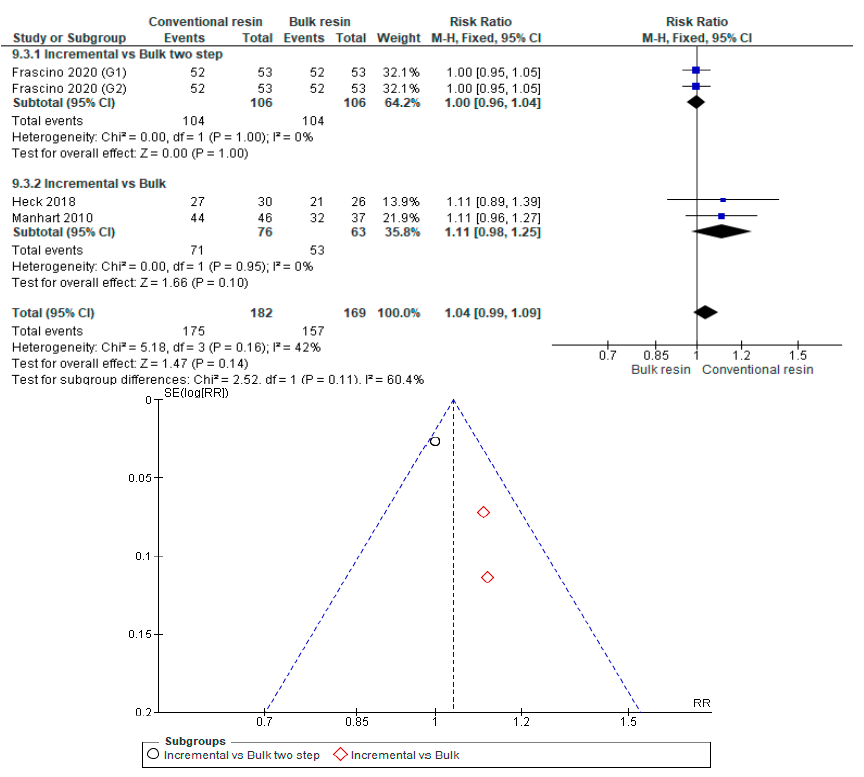
Figure A42. Adequate Tooth Integrity: Conventional Resin versus Bulk Resin According to the Technique Used.